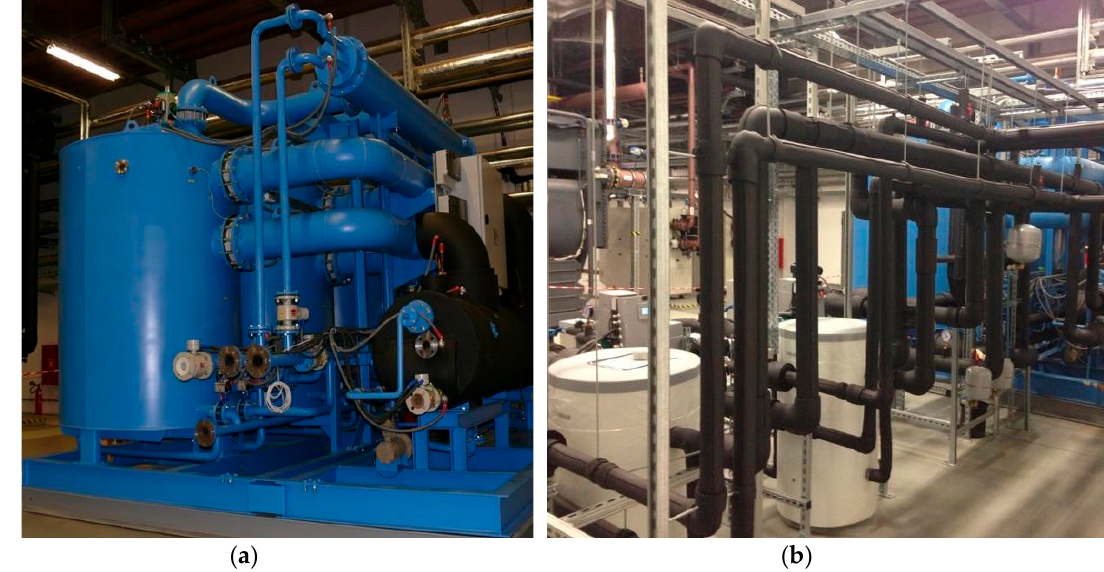
Figure 2. Photo of adsorption chiller: ( a ) Adsorption beds and evaporators; ( b ) complete system.